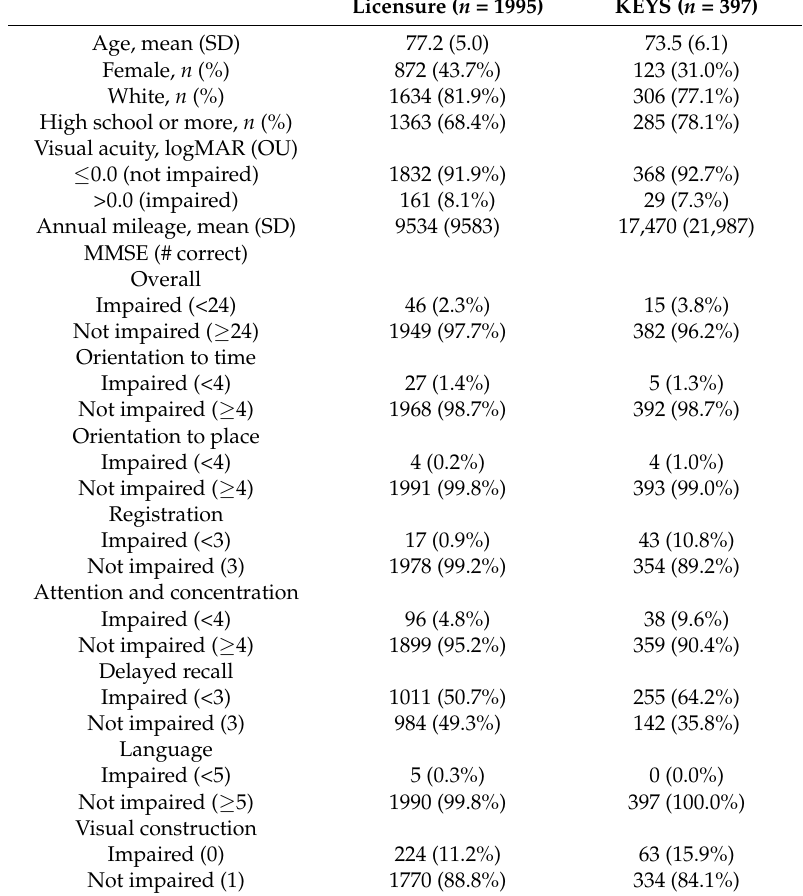
Table 1. Select baseline characteristics in Licensure and KEYS